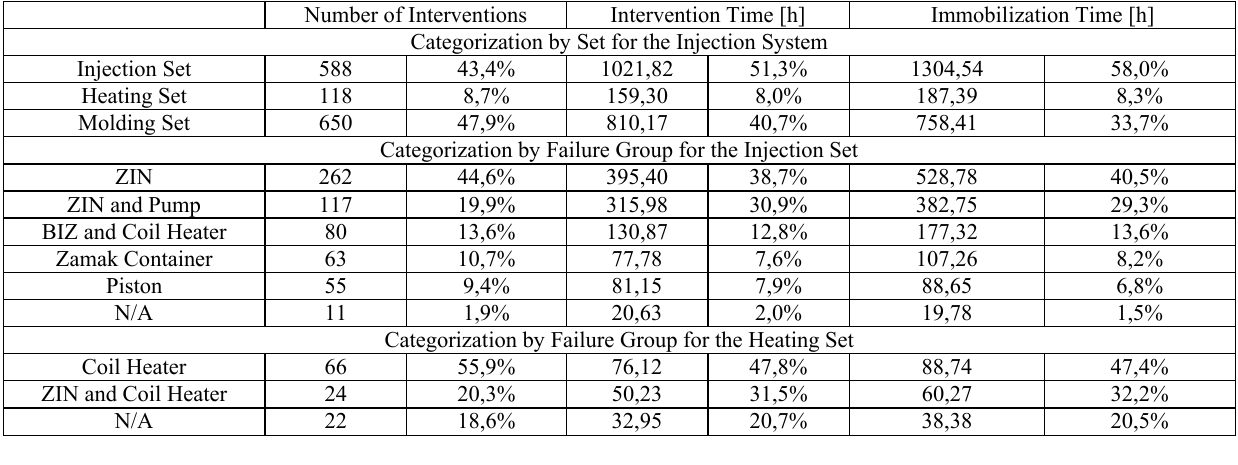
Table 2. Intervention categorization by set for the Injection System, and by failure group for the Injection Set and Heating Set. Number of Interventions